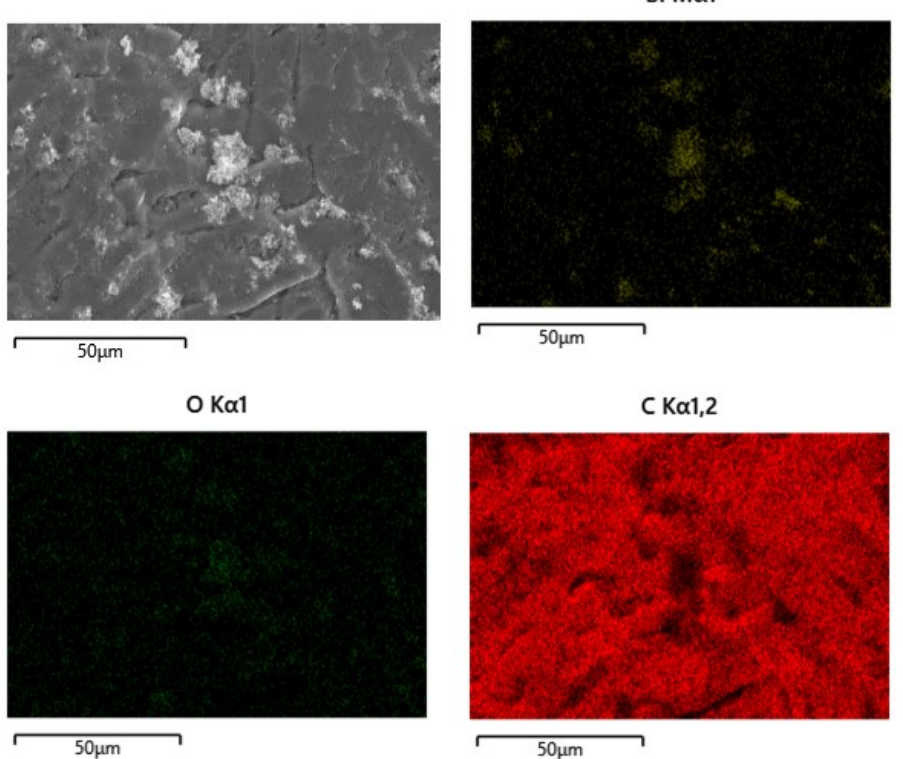
Figure 7. EDS element mapping images of BOC/AC_100.